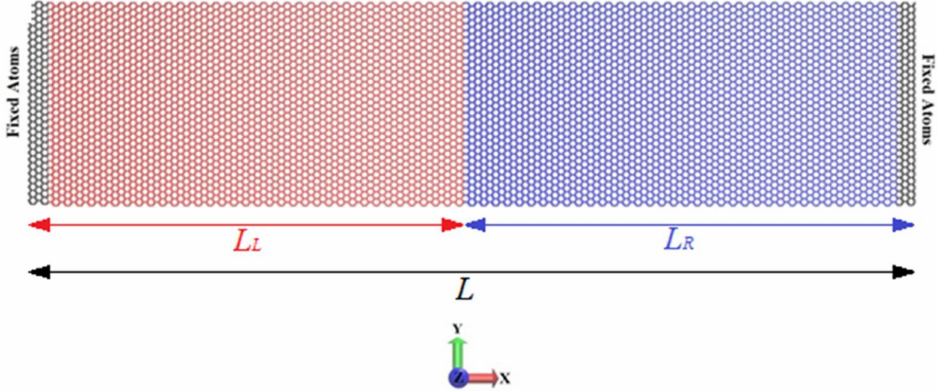
Figure 2. The developed molecular model for the investigation of the thermal conductance of the h-BN and Graphene